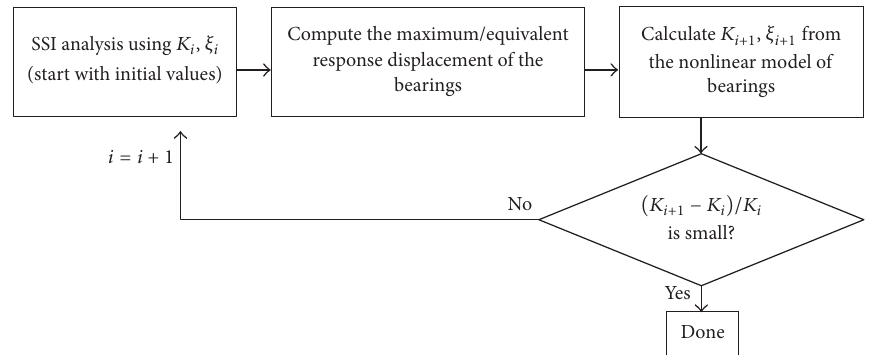
Figure 10: Flowchart of the iteration procedure using the equivalent-linear method.